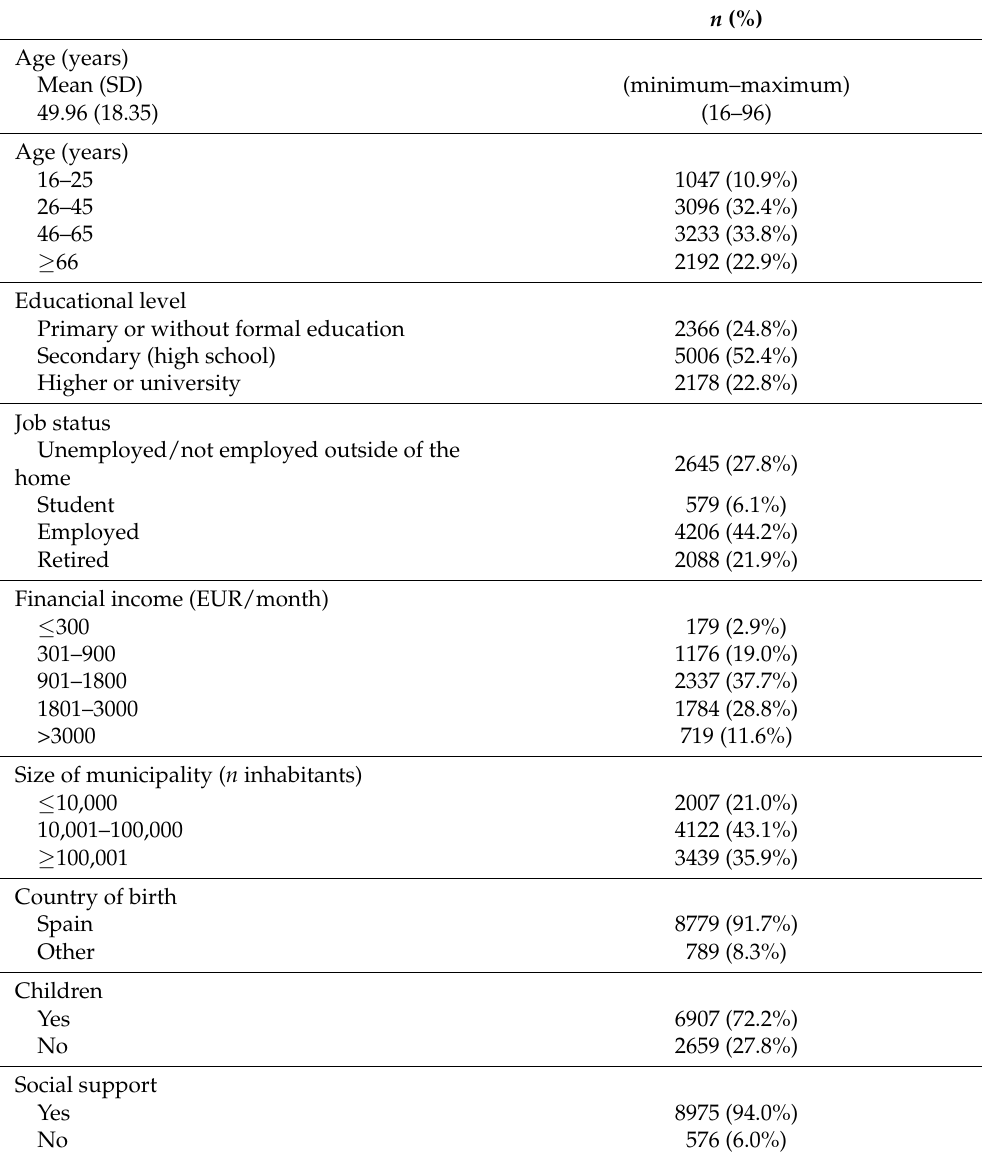
Table 1. Sociodemographic characteristics of the sample ( n =